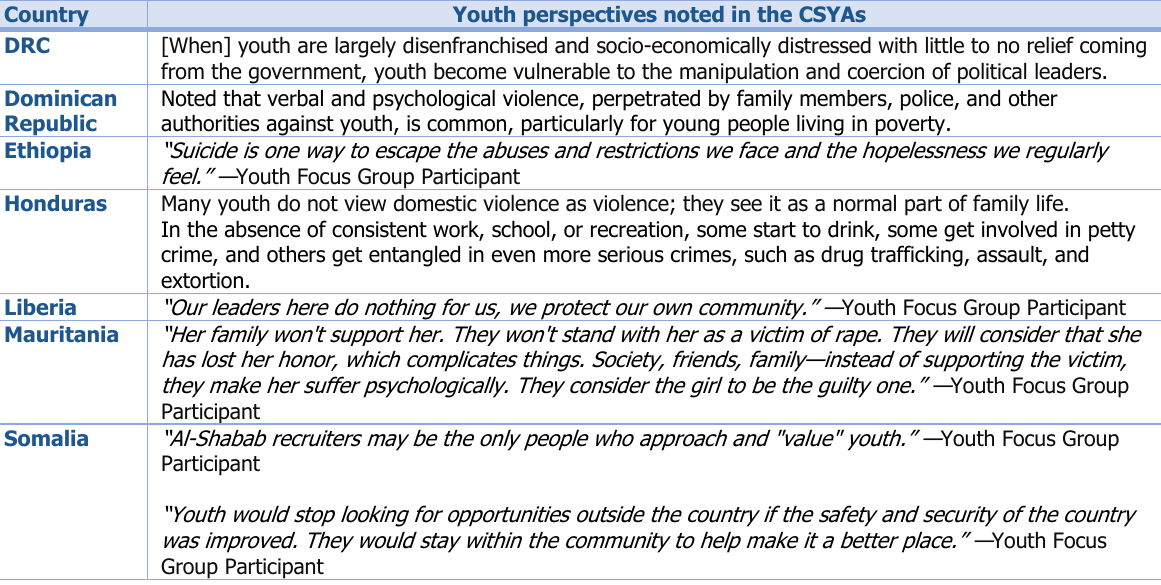
Table 11. Youth-Identified Safety, Security, and Violence Concerns